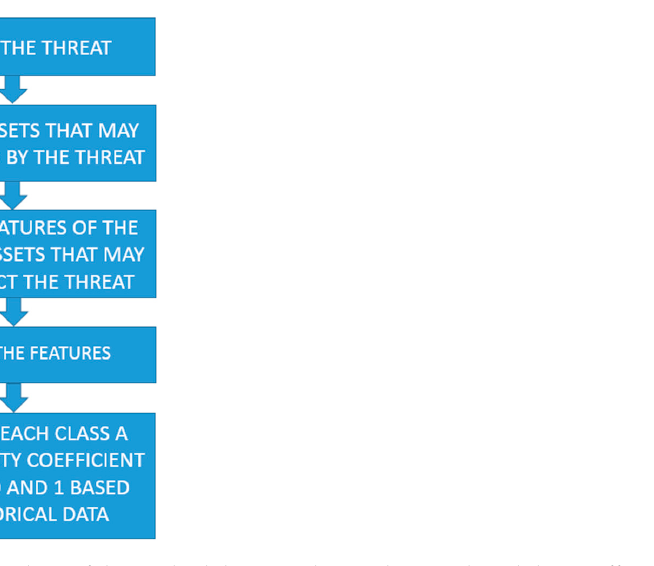
Figure 1. Flow chart of the methodology used to evaluate vulnerability coefficients.